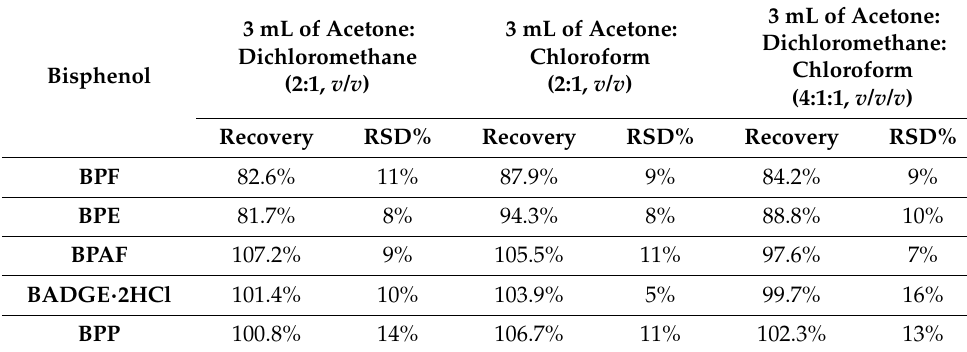
Table 3. The mean recovery values and RSD% of the studied bisphenols in spiked amniotic fluid samples.